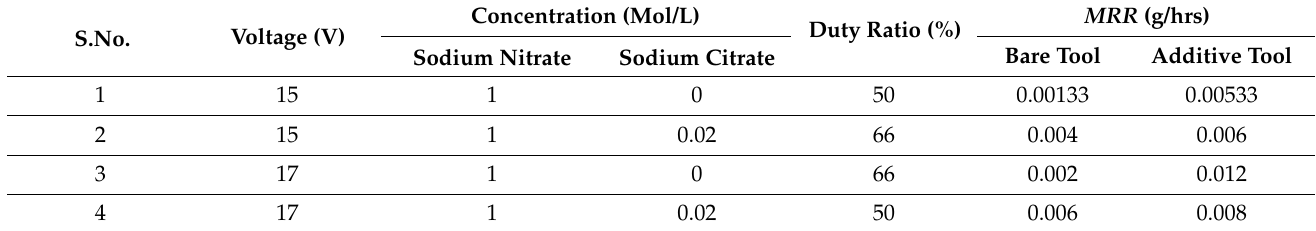
Table 3. Comparison between Bare Tool and Additive Tool for MRR .